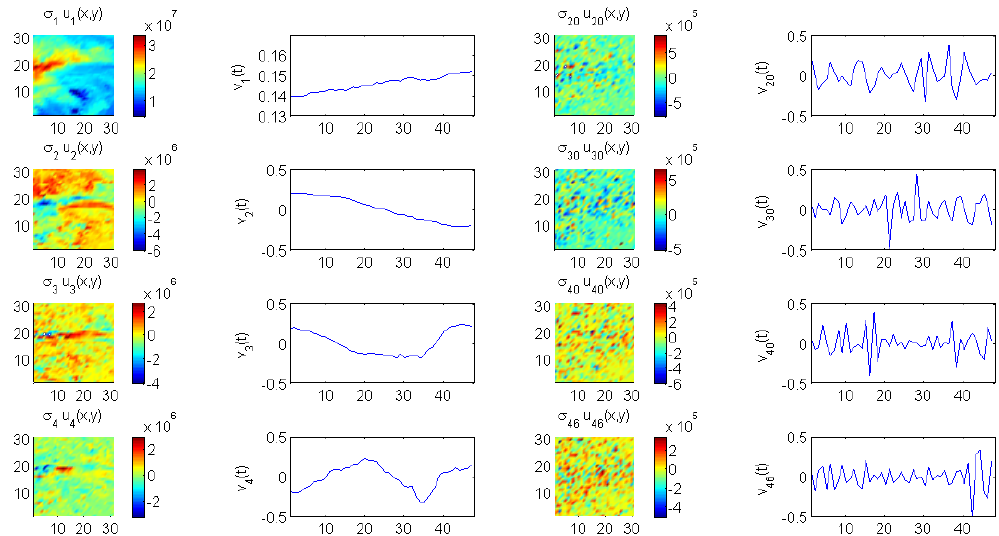
Figure 4. Topos–Chronos decomposition of solar flare activity. Odd columns: spatial modes u k (r i ) ; even columns: temporal modes v k (t j ) , for k = 1, 2, 3, 4, 20, 30, 40, 46. One unit on the time axis equals 12s.